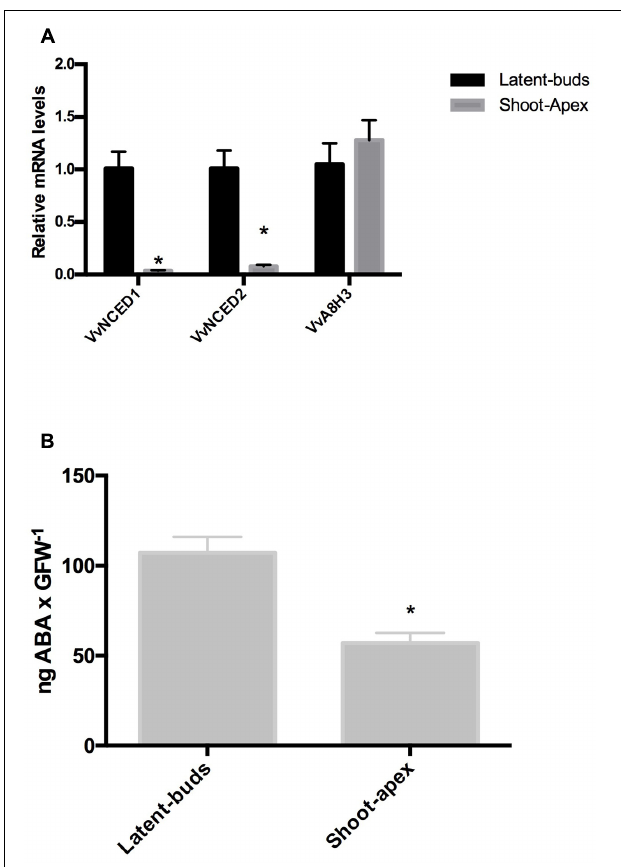
FIGURE 1 | Abscisic acid (ABA) content and ABA metabolism-related genes in the latent buds and shoot apexes of Thompson seedless grapevines. Gene expression analysis of the ABA biosynthesis genes VvNCED1 and VvNCED2 and an ABA catabolism gene VvA8H3 was performed by RT-qPCR and normalized against VvUBIQUITIN (A) . ABA content was determined as described in the Section “Materials and Methods” (B) . Values are the average of three biological replicates ± SD; (asterisk) Student’s t -test ( α = 0.05).